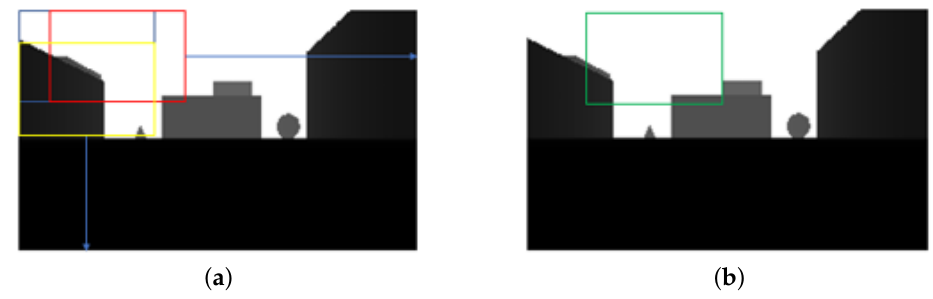
Figure 11. Direction decision from divided sections in [6]. ( a ) Overlapped section, ( b ) Section